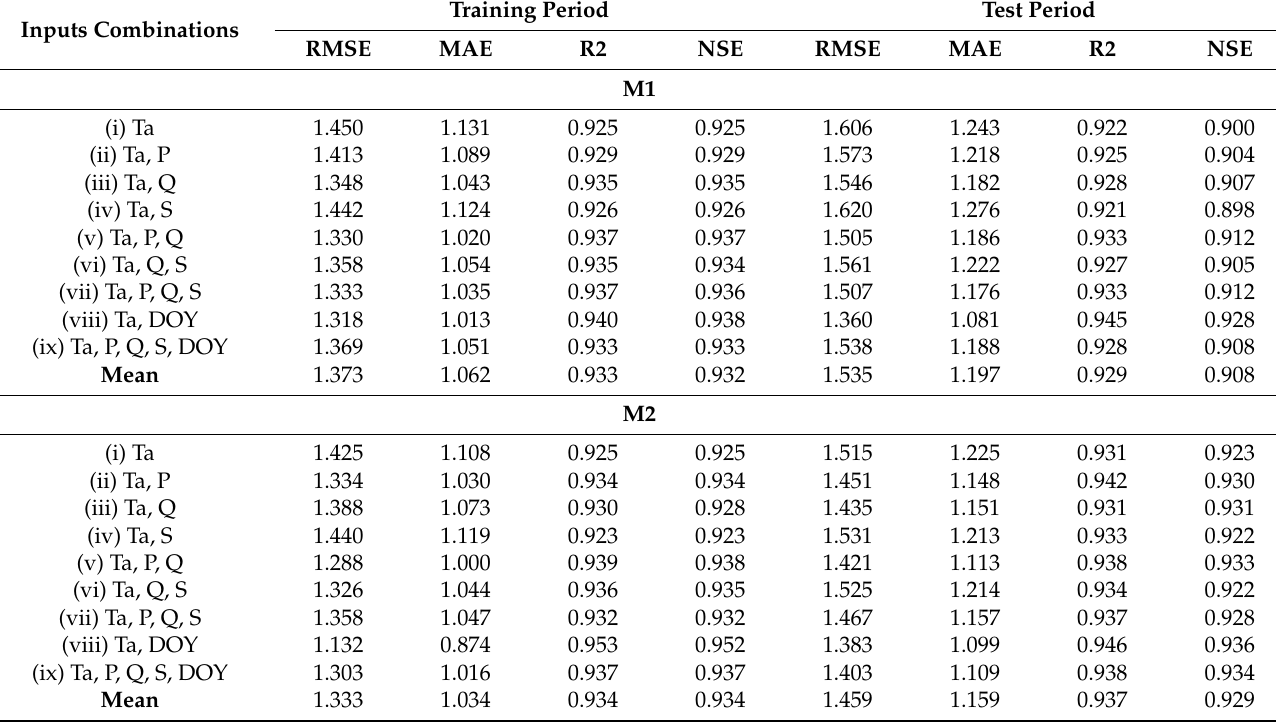
Table 6. Training and test statistics of the models for water temperature